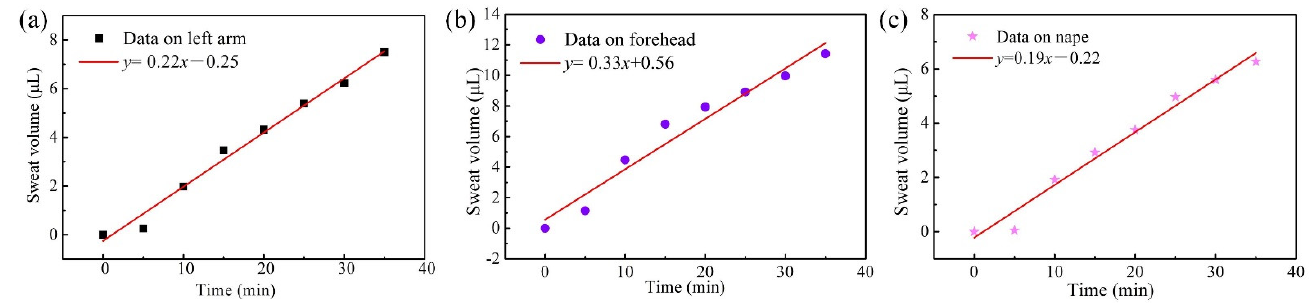
Figure 12. Flow rate of sweat collected from ( a ) the left forearm, ( b ) forehead, and ( c ) nape of the neck measured using the P-SRMC. Table 1. Record of test results for human volunteers.